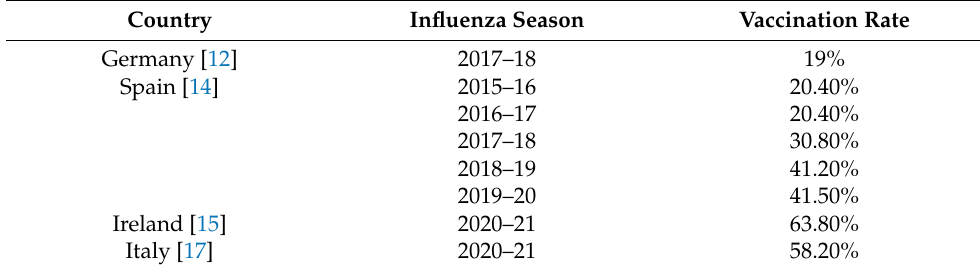
Table 1. Influenza vaccination rate among people with MS in European